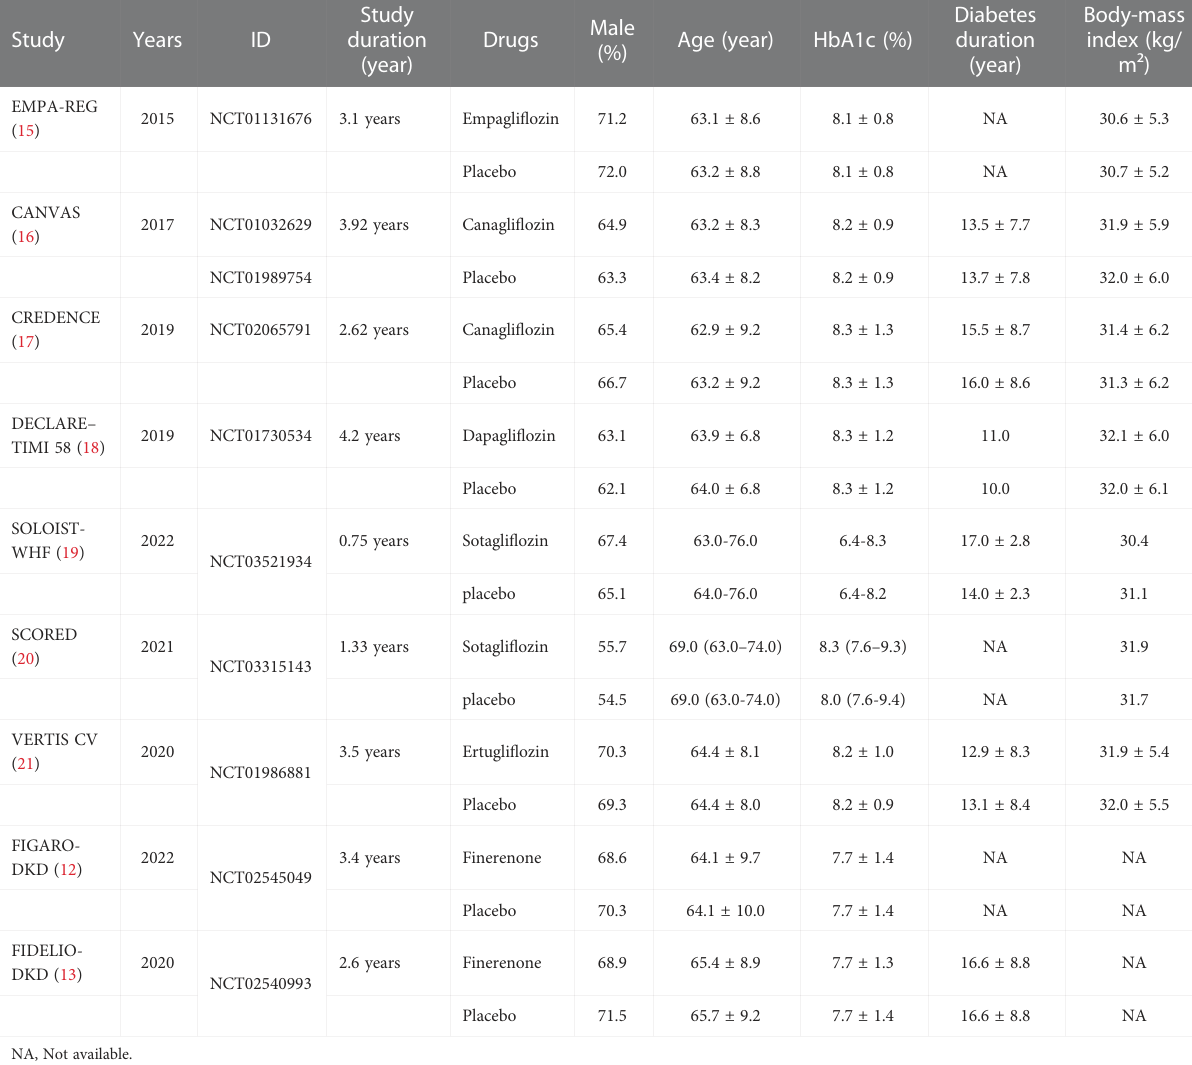
TABLE 1 The basic characteristics of involved studies.